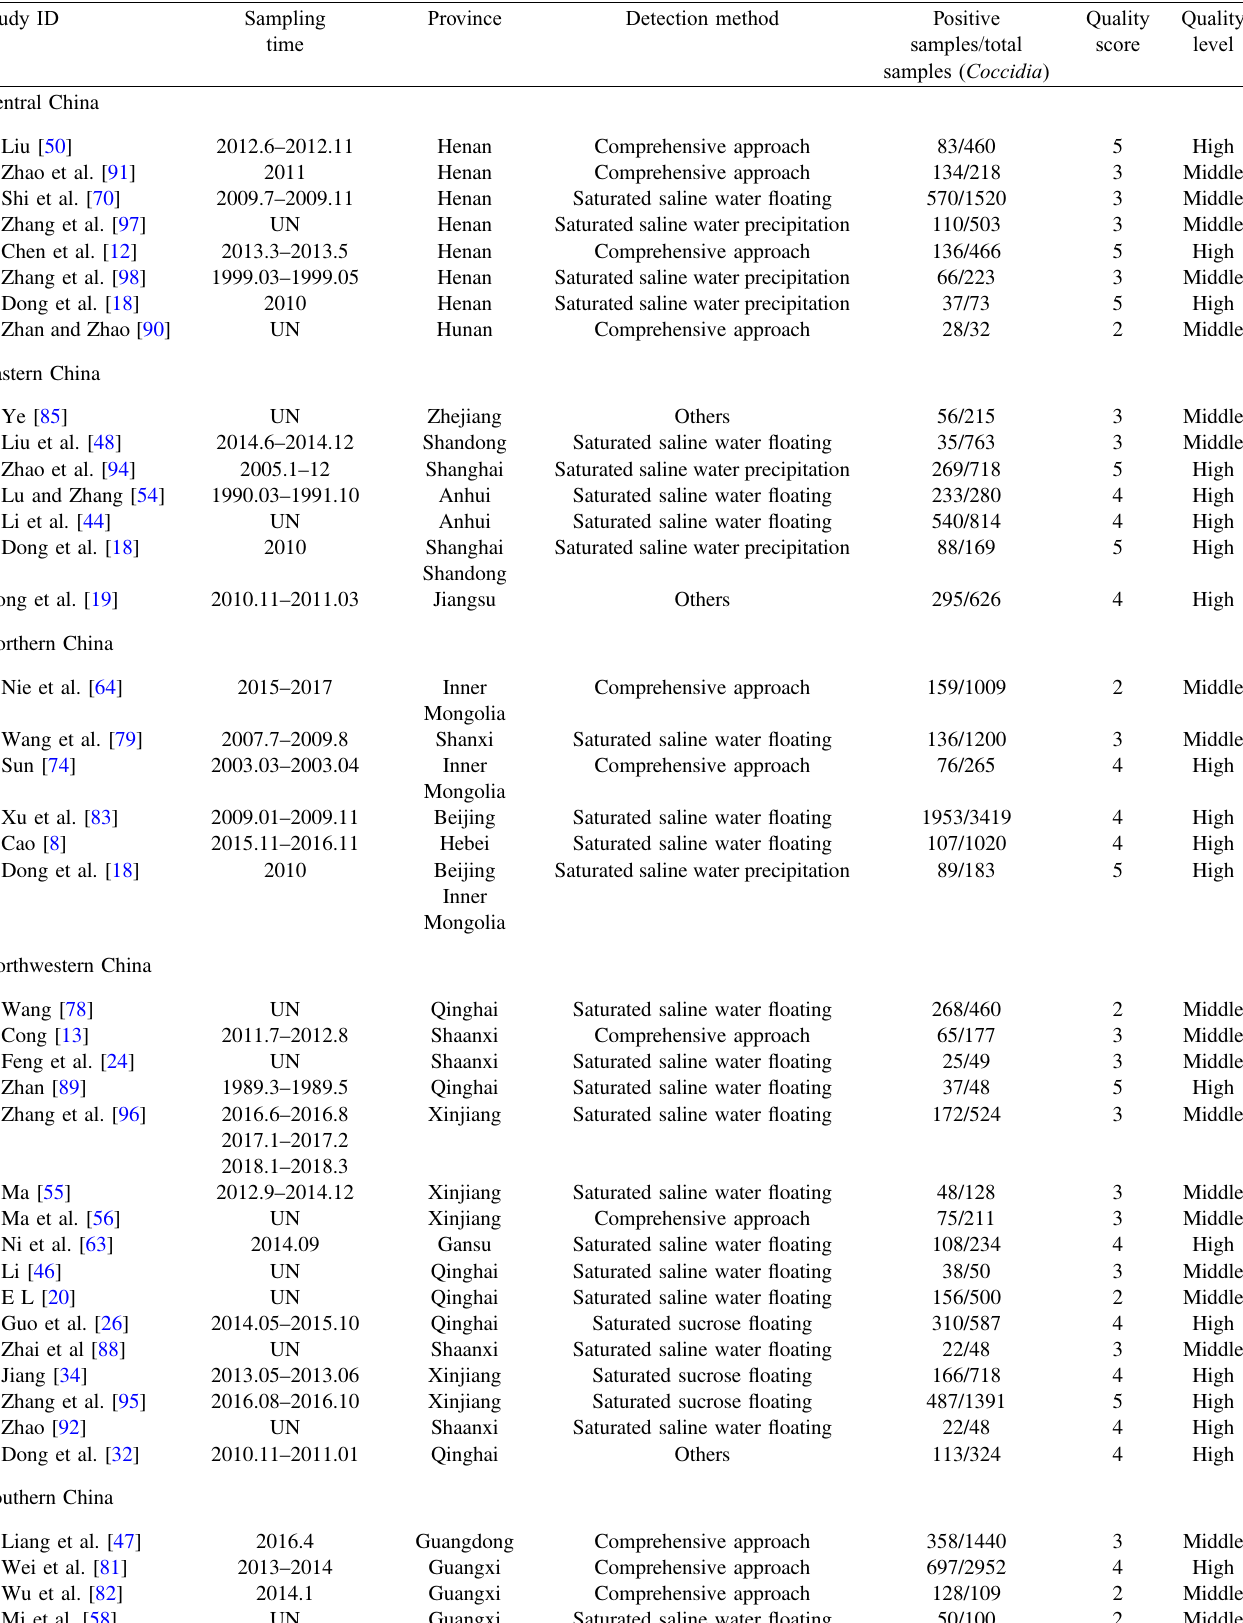
Table 1. Studies included in the